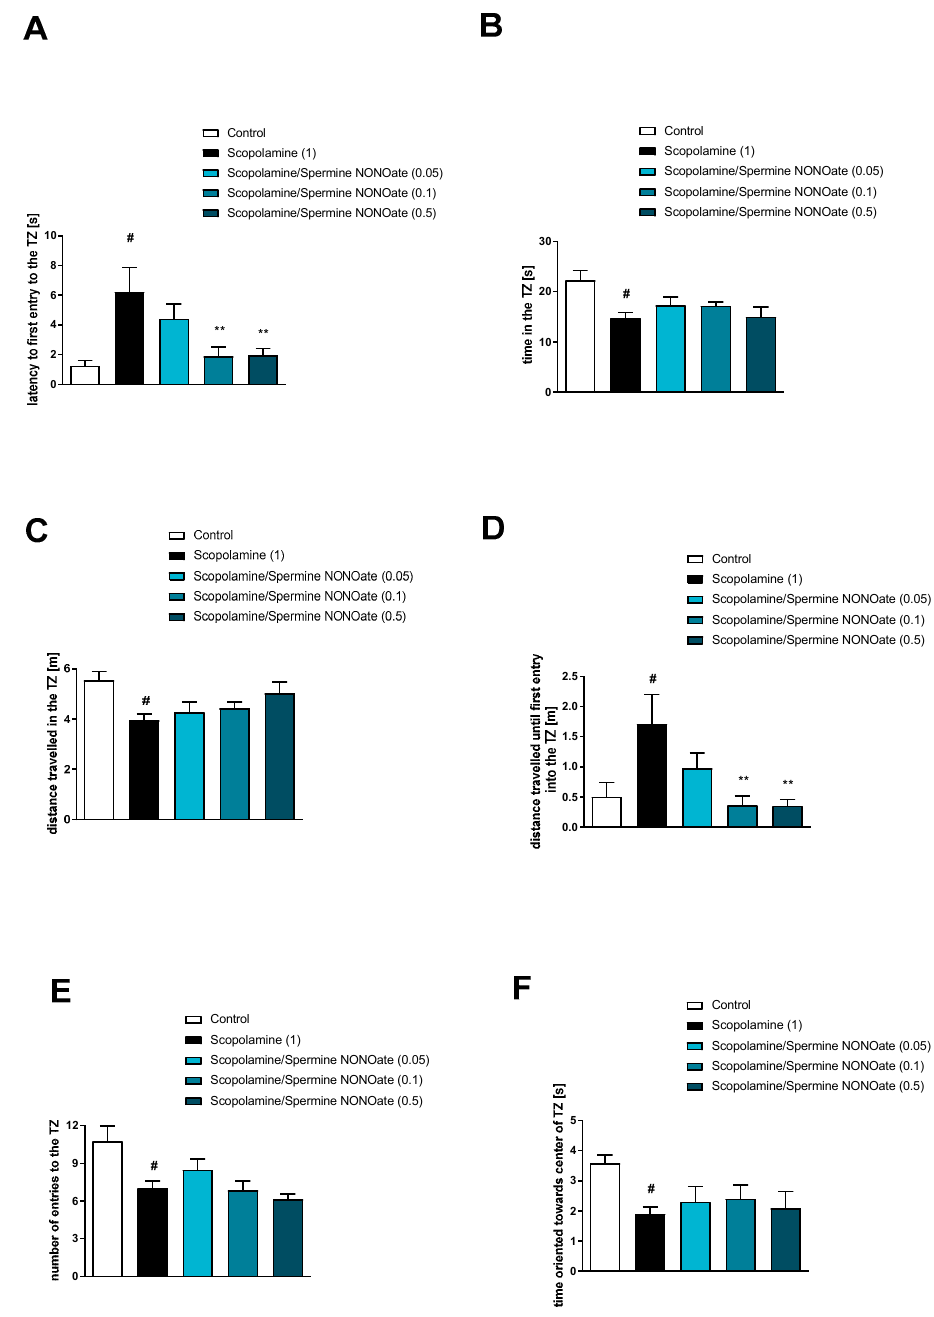
Figure 5. The effects of spermine NONOate on scopolamine-induced deficits in the retention of spatial memory in the MWM of CD1 mice. TZ-related parameters. ( A ) latency to the first entry into the TZ, ( B ) the time in the TZ, ( C ) the distance travelled in the TZ, ( D ) the distance travelled until the first entry into the TZ, ( E ) the number of entries into the TZ, and ( F ) the time oriented towards the centre of the TZ when inside the zone. The values are expressed as the means ± SEM. # p < 0.001 vs. control group and ** p < 0.005 vs. scopolamine-treated animals (N =